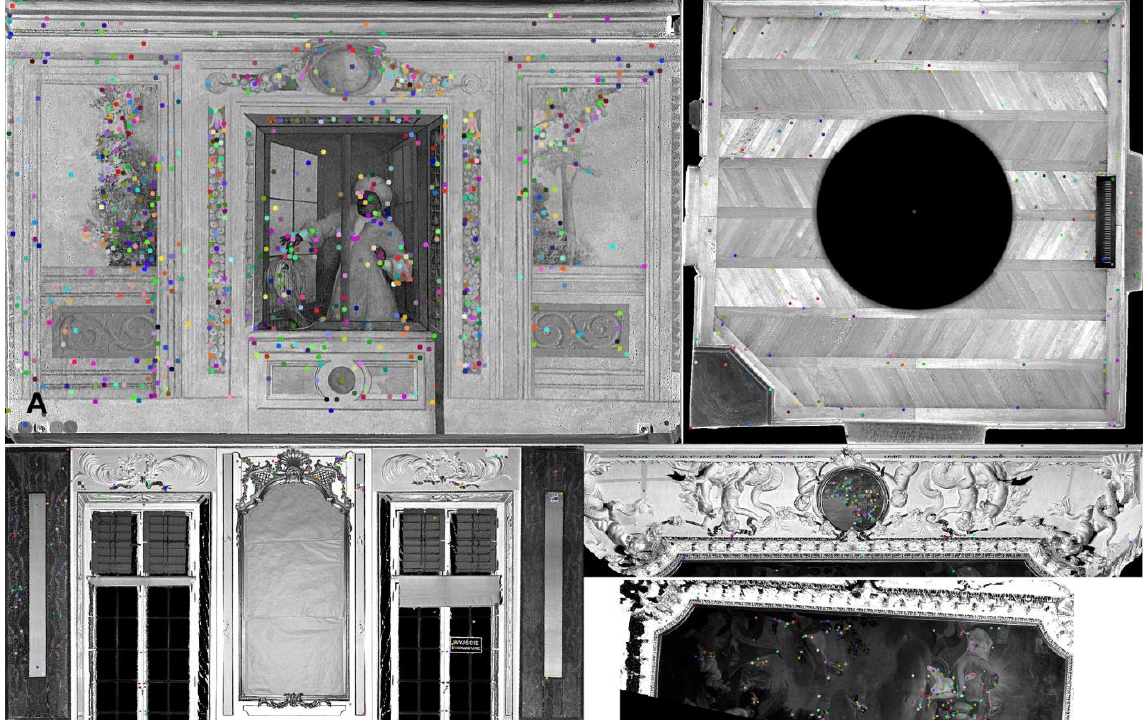
Figure 2: An example of the distribution of control points in images: a) the first test site, b) the second test